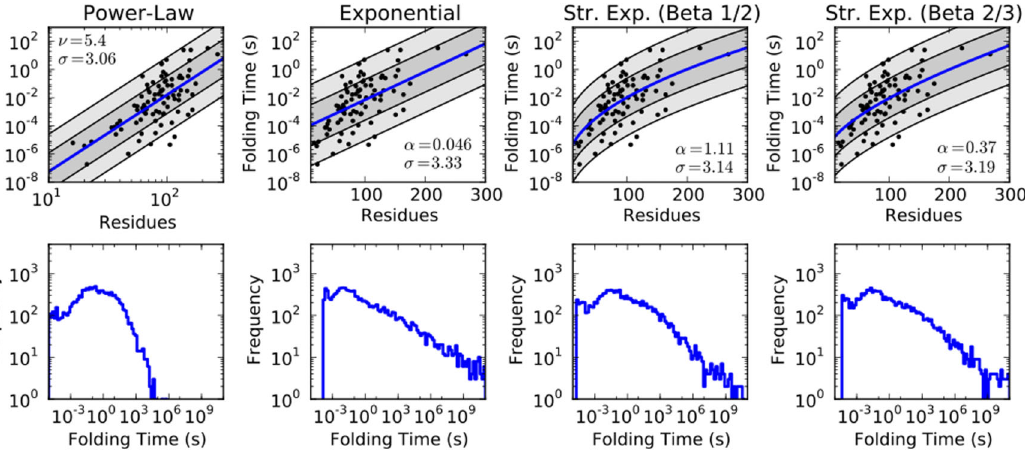
Figure 2. The predicted models for the folding rate law, overlaid with measurements of folding times (top), and the putative folding time distributions these models imply (bottom). Parameter values derived from a maximum likelihood fit are displayed, along with intervals indicating the spread in the fit probability distribution. Dark grey shading indicates a factor of e s , while light grey indicates e 2 s .